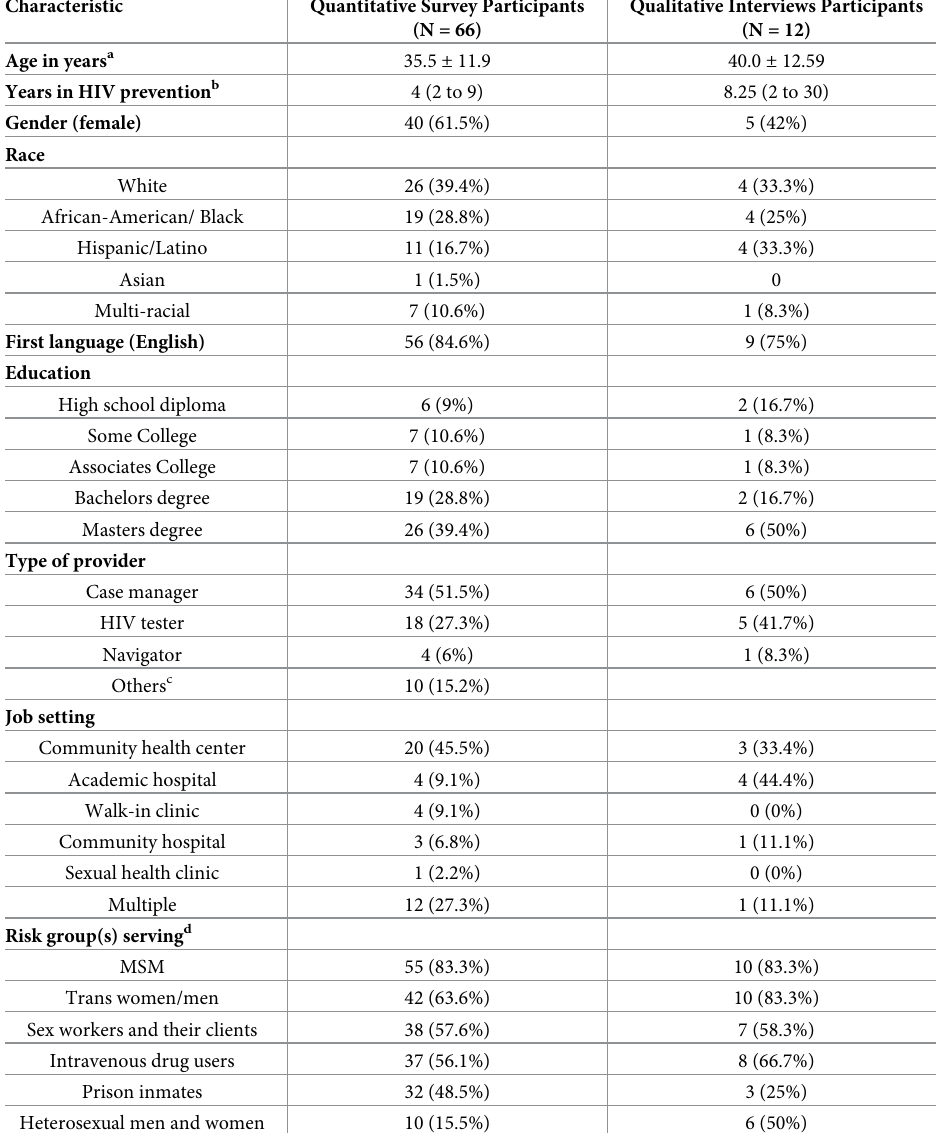
Table 1. Demographic characteristics of non-prescribing providers in